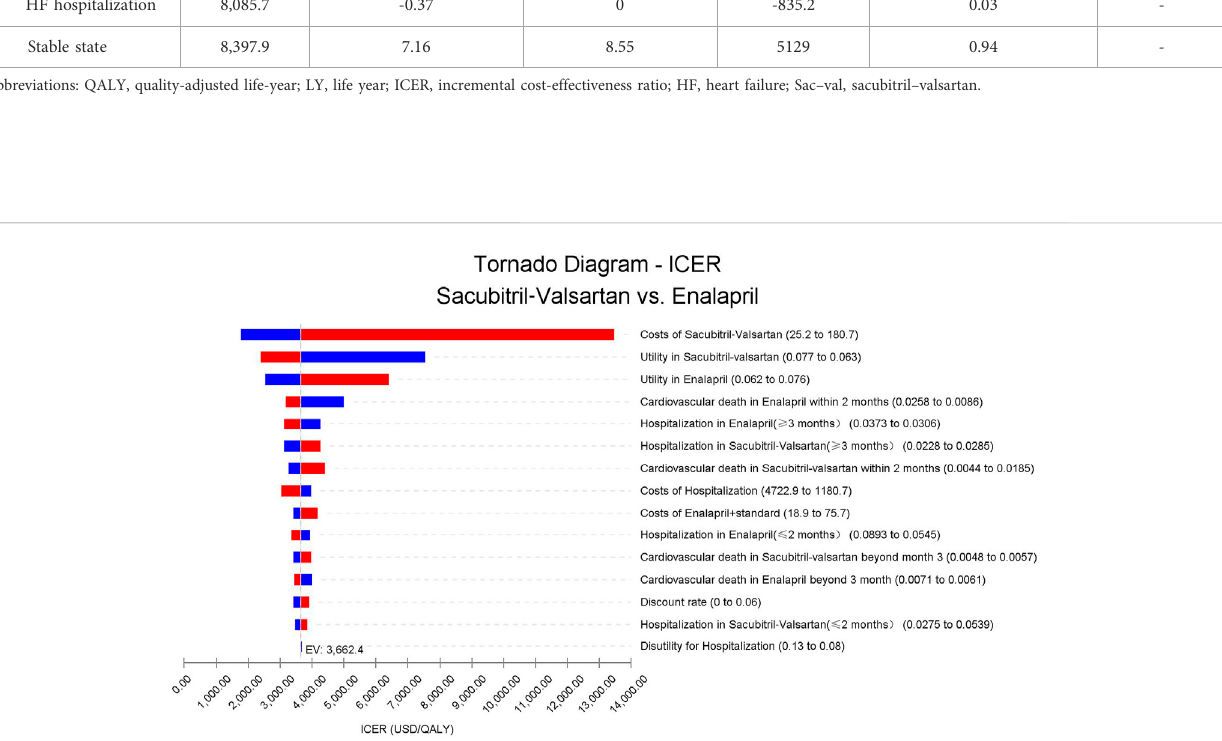
FIGURE 3 Abbreviation: ICER, incremental cost-effectiveness ratio. Tornado diagram based on the one-way sensitivity analysis. Costs of sacubitril – valsartan impact the most on the ICER fl uctuation; other input parameters have little impact on